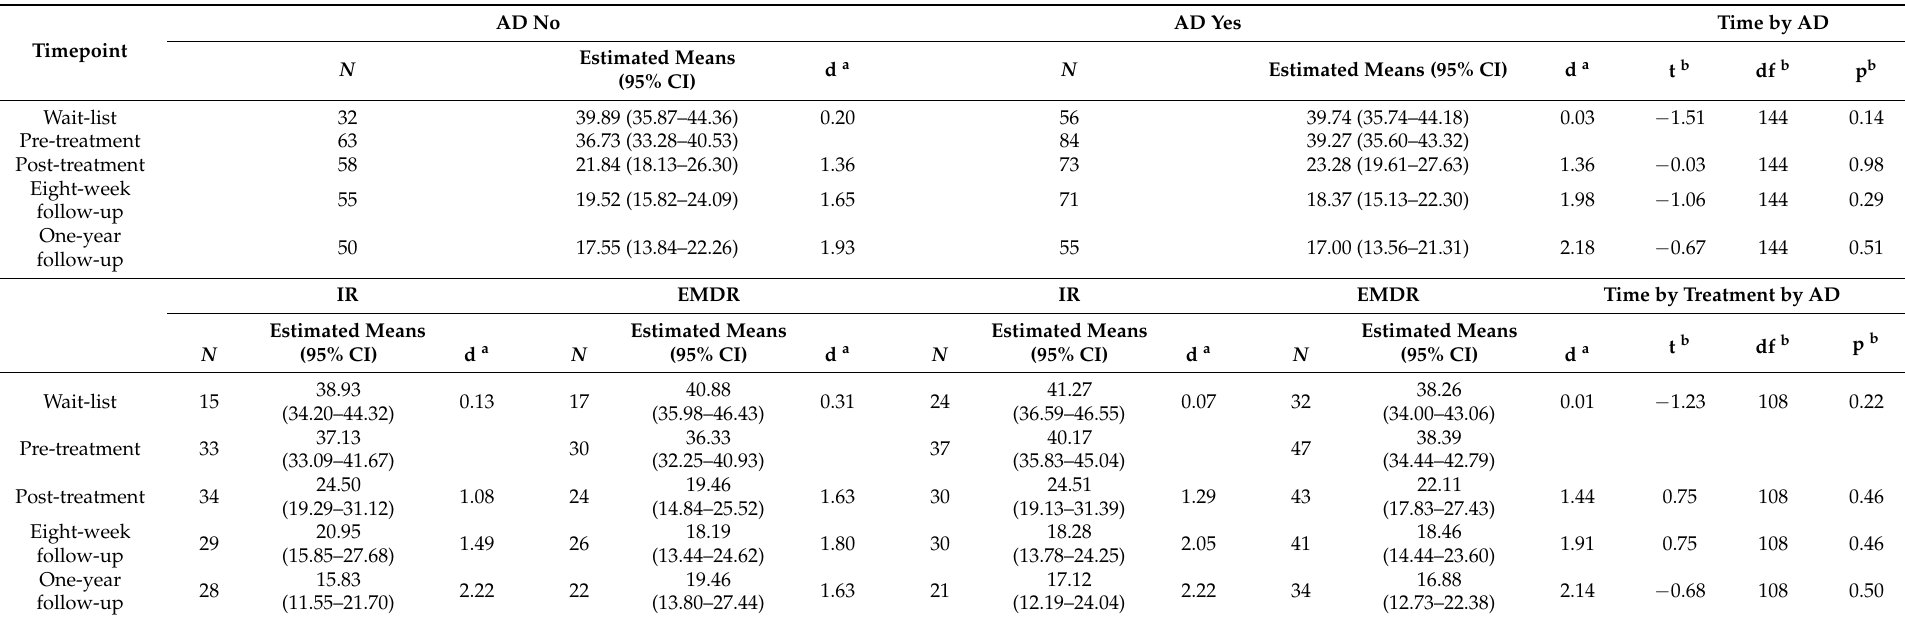
Table 3. Primary treatment outcome CAPS-5 by AD diagnosis and treatment condition across all assessment